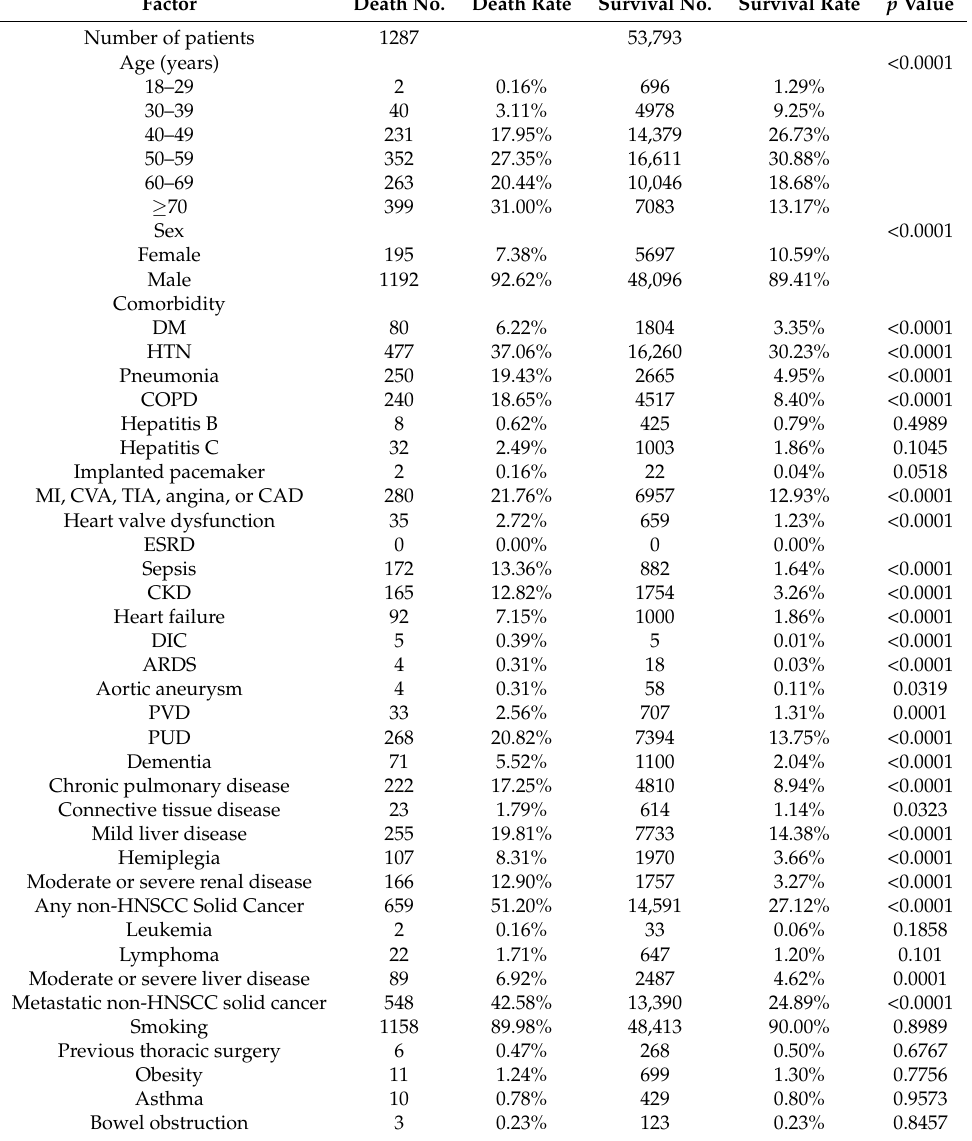
Table 1. Demographic characteristics between death within 90 days and survival groups receiving curative surgery in locoregionally advanced head and neck squamous cell carcinoma patients. Factor Death